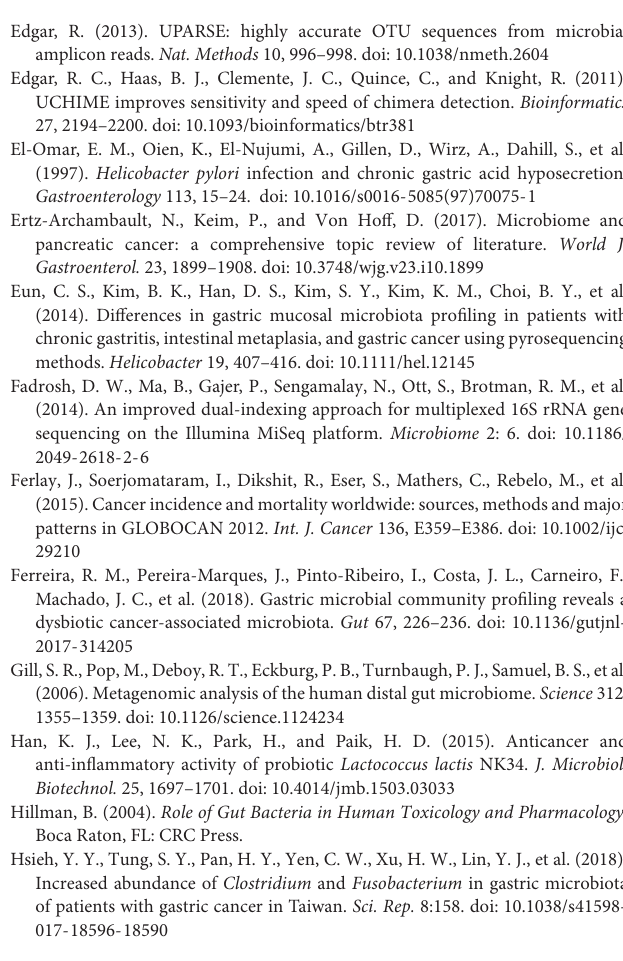
TABLE S5 | Significantly differential bacteria identified among the top 20 abundant genera of the cancer and non-cancer groups. TABLE S6 | Nearest sequence taxon index (NSTI) scores for all